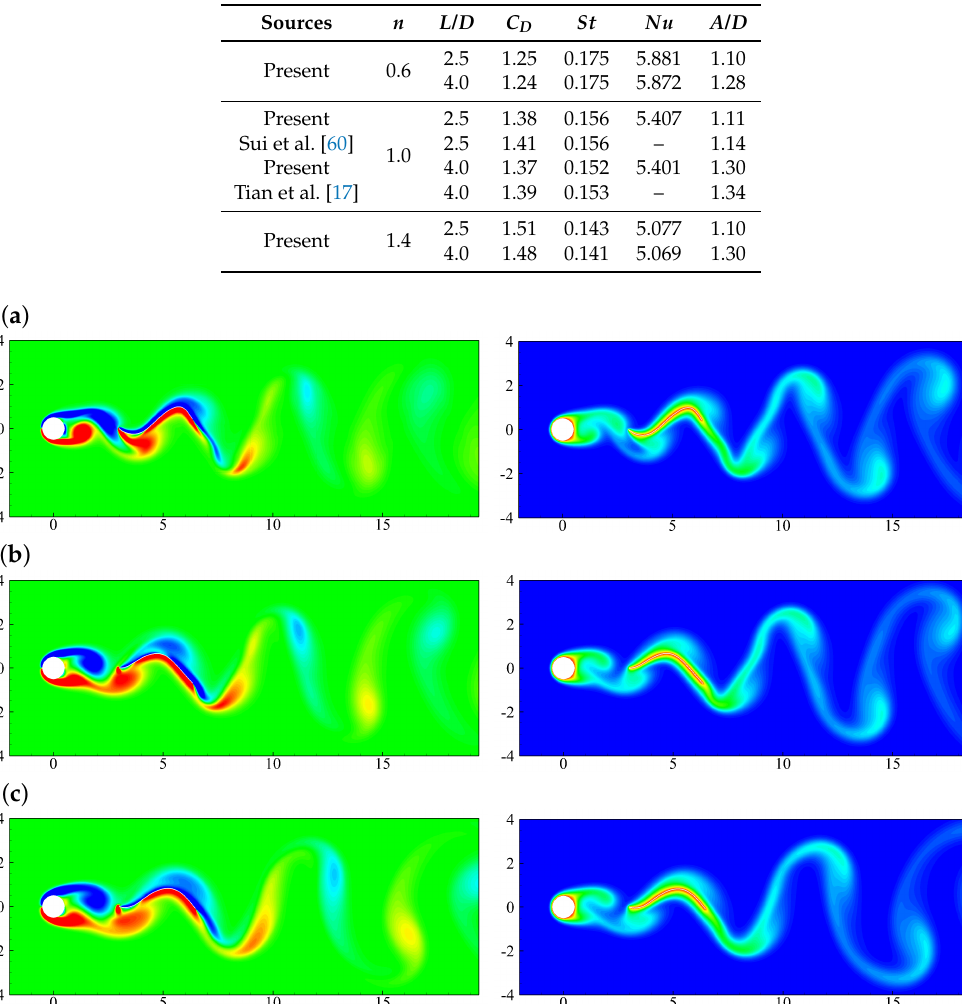
Figure 7. Schematic of heat transfer around a stationary cylinder with a detached filament in power-law fluid flow. Table 4. The averaged drag coefficient ( C d ), the Strouhal number ( St ), the averaged Nusselt number ( Nu ) of the cylinder, and the vertical flapping amplitude A / D of the trailing end of the filament.